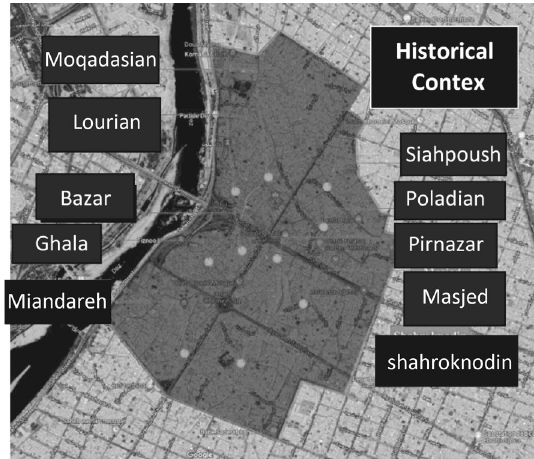
Fig. 7 Areas of historical significance and the surveyed